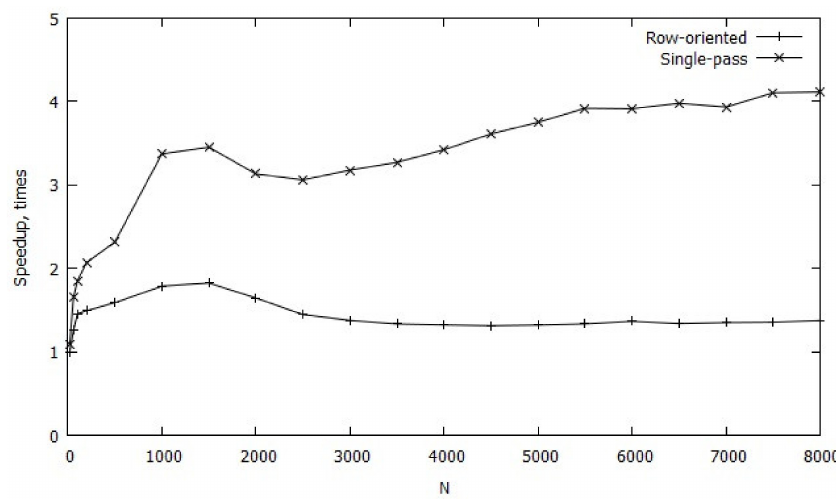
Figure 10. The speedup of the optimized software relative to the classical transformation scheme.